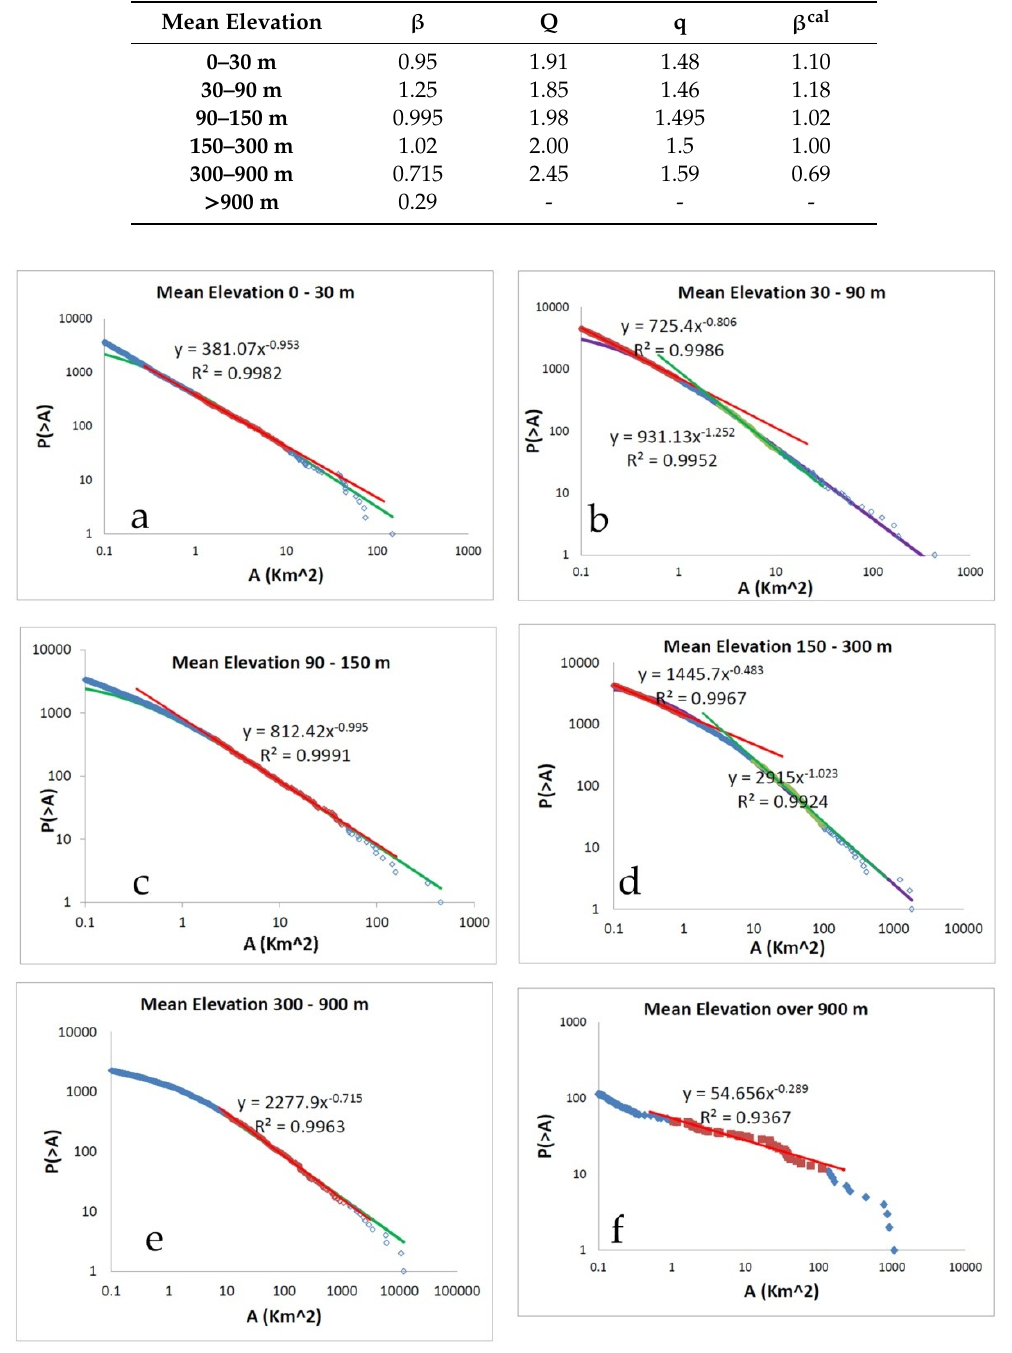
Figure 7. The drainage distribution for the six elevation classes defined in Greece. A power law fitting is presented along with the Q-exponentials. The scaling exponent β and the Q values as presented in Table 1 (see text). Table 1. The power law exponent β , the Q and q non extensive parameters and the β cal value as estimated for each of elevation class of Greece drainages.